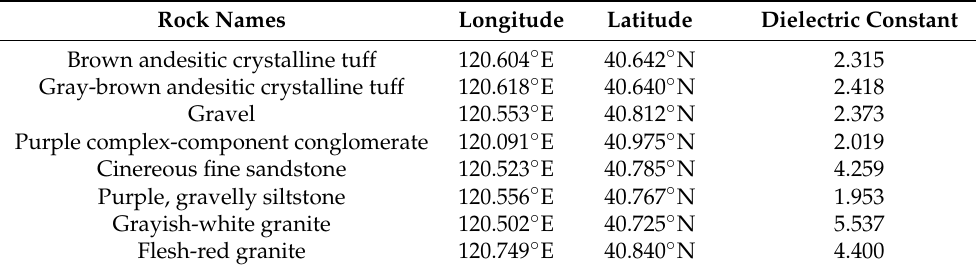
Table 9. Dielectric constants of rocks in other regions at 5.4 GHz frequency